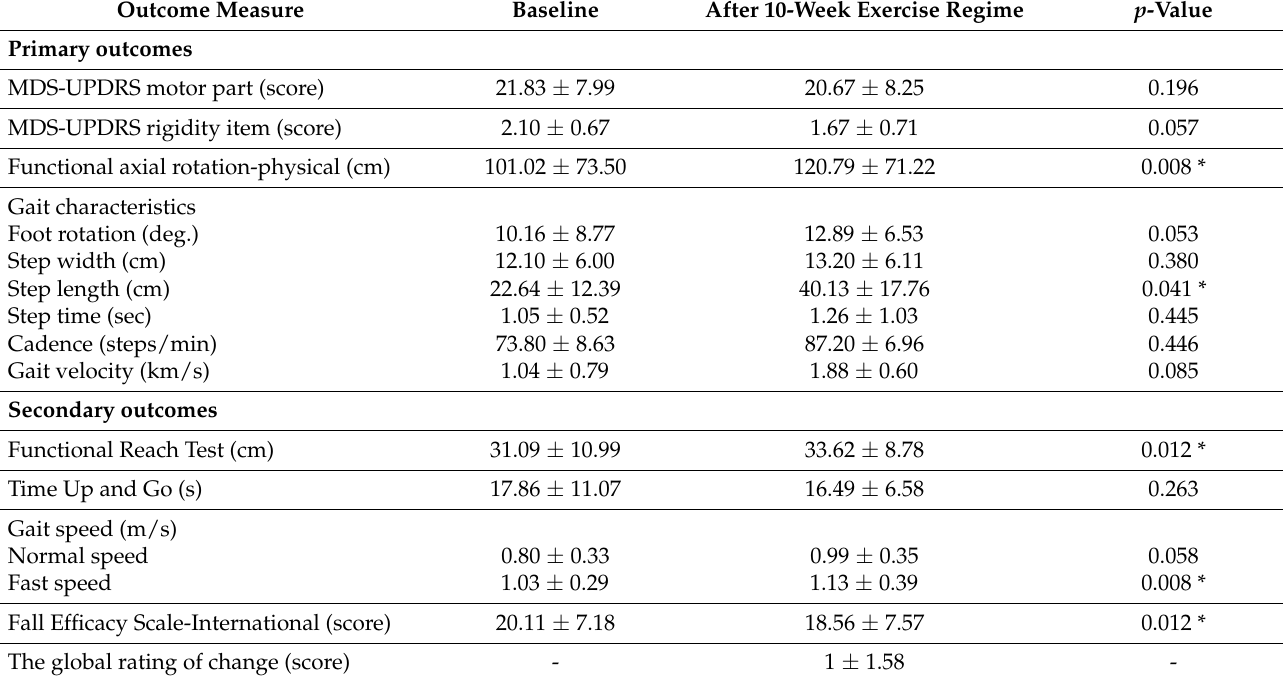
Table 4. Comparison of primary and secondary outcomes between the baseline and post-exercise assessments within the home-based exercise groups (HOME). The p -values refer to the differences within group in two assessments: the baseline and after the 10 week exercise regime. Values are mean ± standard